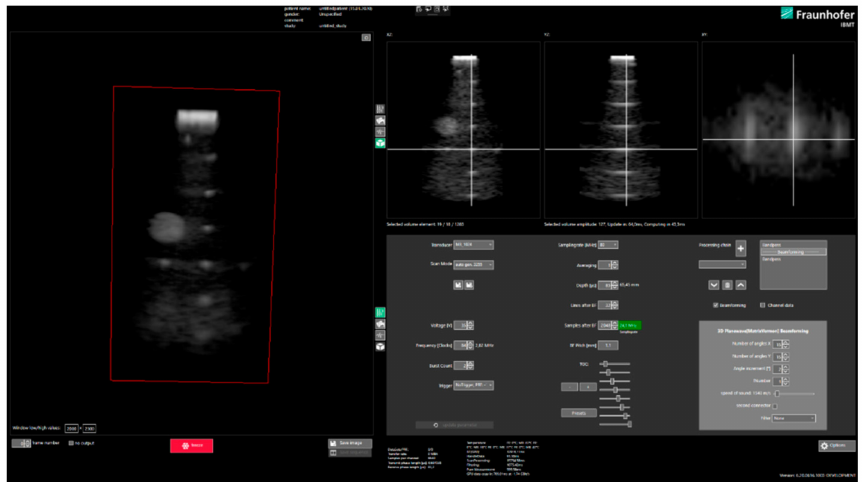
Figure 13. Real-time volumetric imaging user interface “USPilot” with device parameterization, volumetric rendering and orthogonal slice